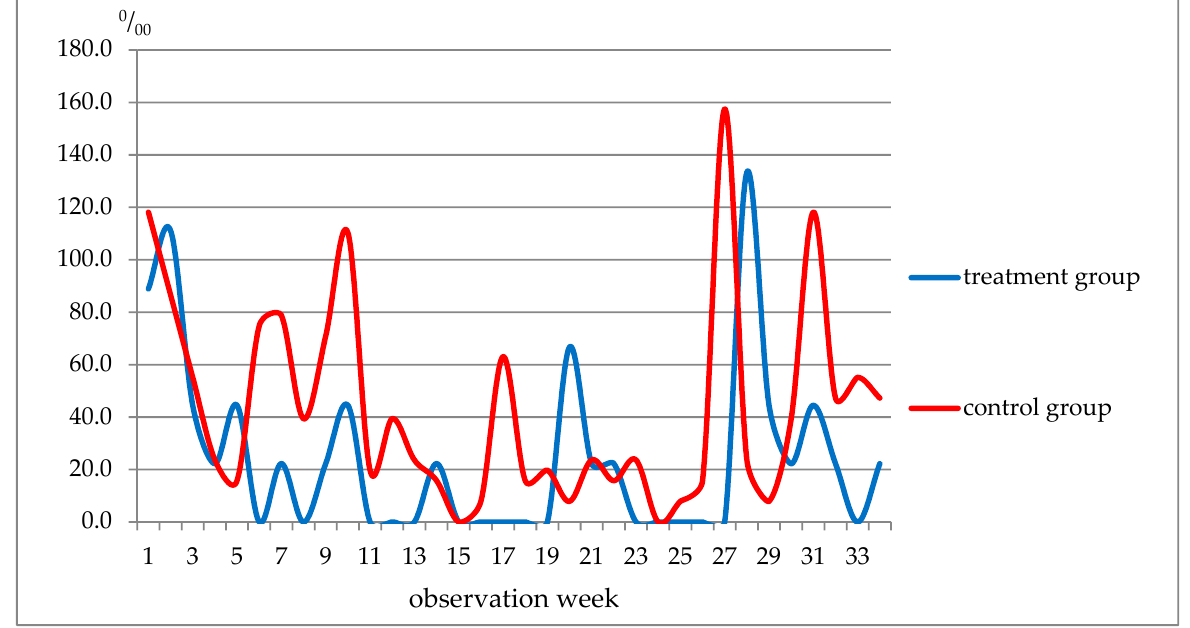
Figure 2. The incidence of ARI URT and flu among students of the control group by observation weeks, ‰. In the treatment group, diseases of the skin and subcutaneous tissue were diagnosed Table 13. Morbidity patterns in the control group by the most prevalent disease classes,%, only in week 21, whereas in the control group, they were diagnosed in weeks 2–3, 6–10, 13, 15, 19–23, 28–29 (Figure 3). The incidence rate in the treatment group was 22.2‰, and in the control group, it was 126.0 ‰.